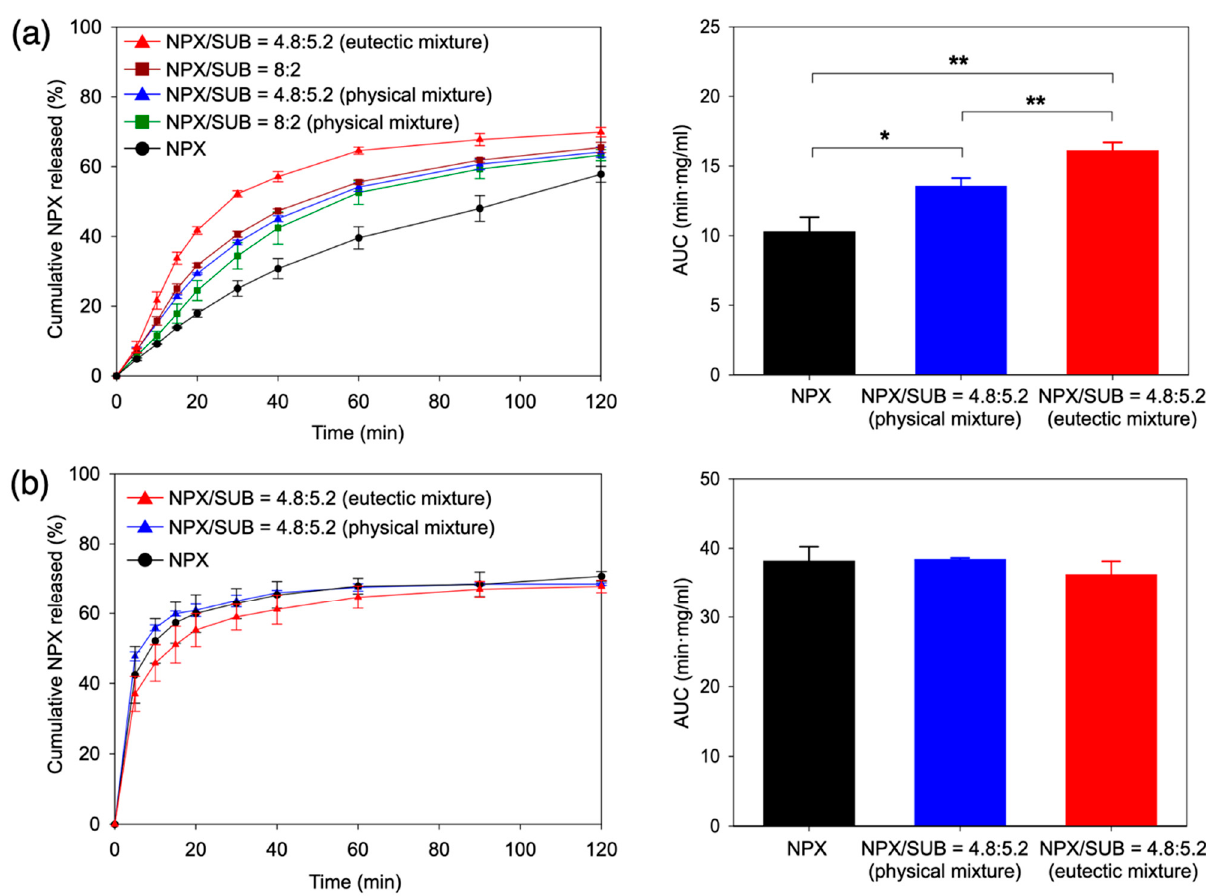
Figure 3. Dissolution profiles of the NPX/SUB eutectic mixture (4.8:5.2) in comparison with the physical mixture and pure NPX: ( a ) pH 5.0 (NPX/SUB = 8:2 was additionally shown); ( b ) FeSSIF ( n = 3 for both cases). The results of two-sample t-tests for the area under the curve (AUC) are also presented for NPX/SUB = 4.8:5.2 (eutectic and physical mixtures) and neat NPX (* and ** indicate the statistically significant differences with p < 0.05 and p < 0.01,